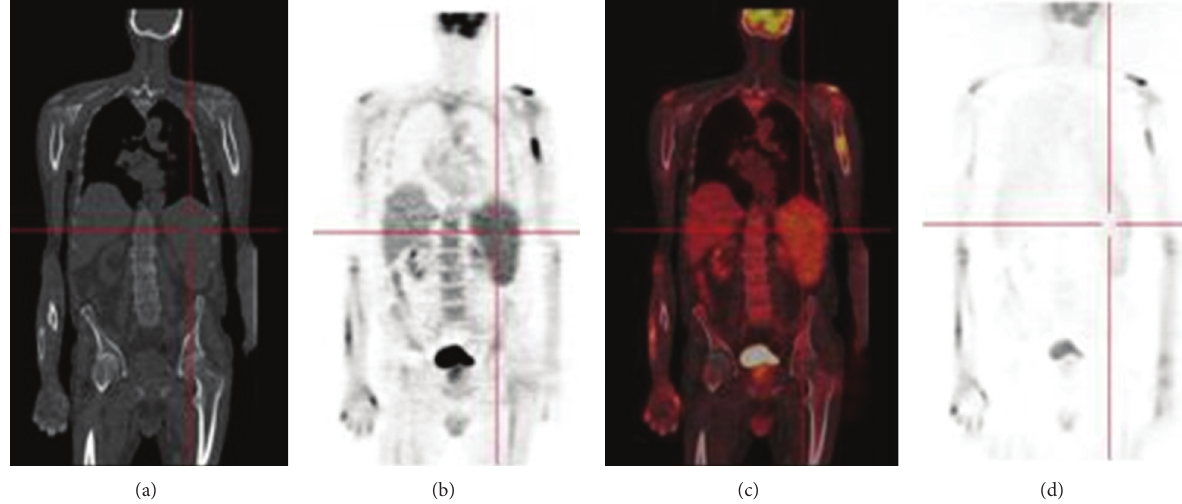
Figure 1: The whole-body 18 FDG-PET exam. Selected coronal slices of computed tomographic scan (a); F-18 FDG PET scan (b); PET-CT fusion (c); maximum intensity projections (d). Intense heterogeneous activity maximal standard uptake value (msuv) = 6.1 on bone marrow and splenic tissue msuv = 2.9